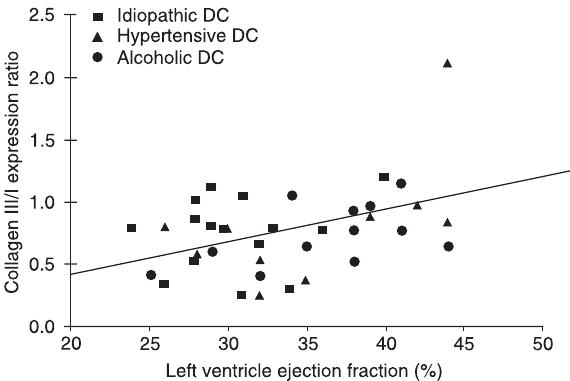
Figure 3. Linear regression between left ventricle ejection frac- tion and ratio of collagen type III/I mRNAs determined by RT- PCR in all patients with dilated cardiomyopathy (DC; Pearson’s correlation coefficient = 0.44, P = 0.005). The different patient groups are indicated by squares for idiopathic, triangles for hy- pertensive, and circles for alcoholic